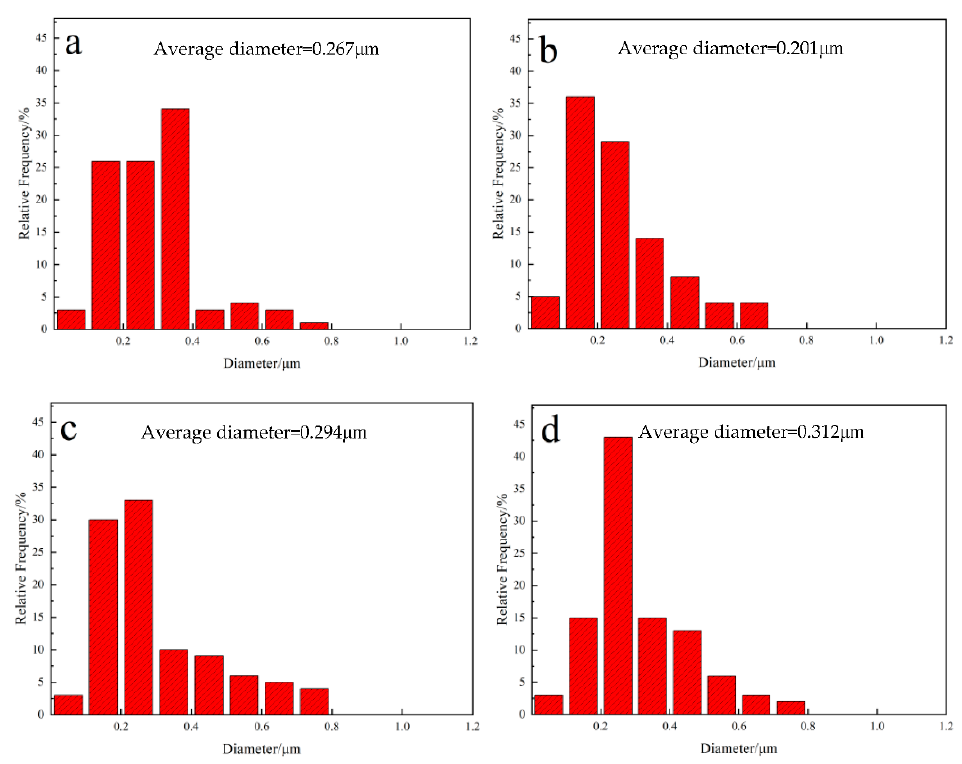
Figure 8. SEM images at different addition of AgNO 3 : ( a ) the addition of 0.1 wt%; ( b ) the addition